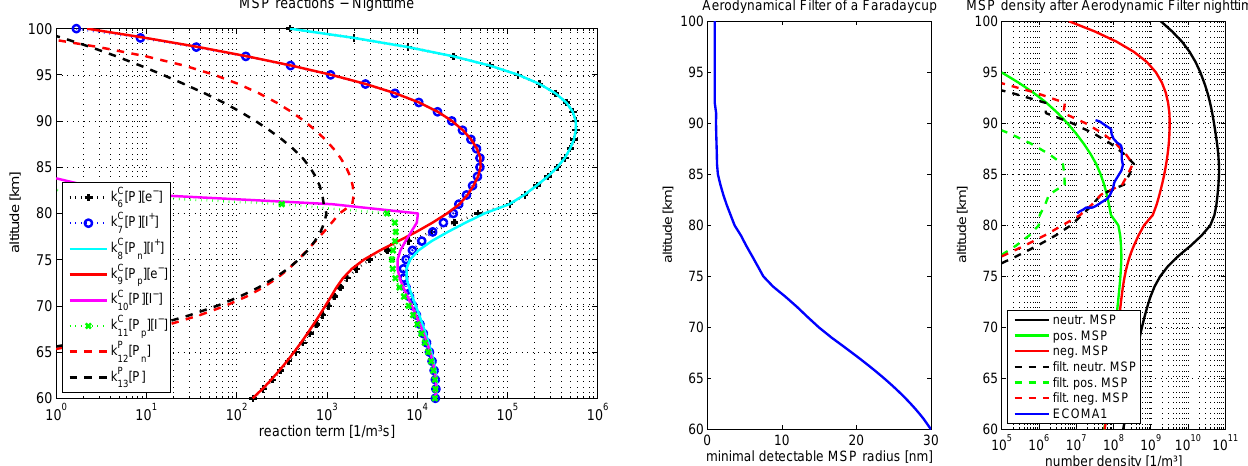
Fig. 7. Height profiles of MSP photoreaction rates (dashed lines) and plasma capture rates by MSP (solid lines); compare legend en- tries with Equations 12–14.